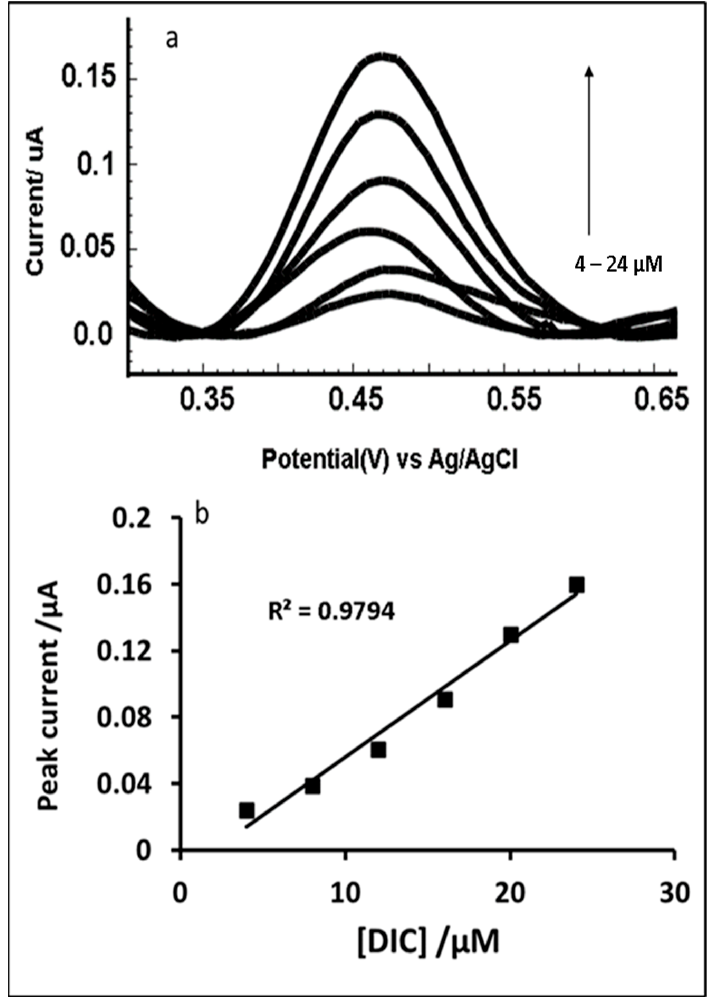
Figure 5. ( a ) Differential pulse voltammetry (DPV) of different concentrations of dibucaine hydrochloride (DIC) (as arrow indicates) (4, 8, 12, 16, 20 and 24 µM) at the water | 1,6-DCH microinterface. ( b ) Calibration curve for DIC + ion transfer. Table 2. Comparison of the proposed DPV method with some previous electrochemical methods to determine dibucaine.